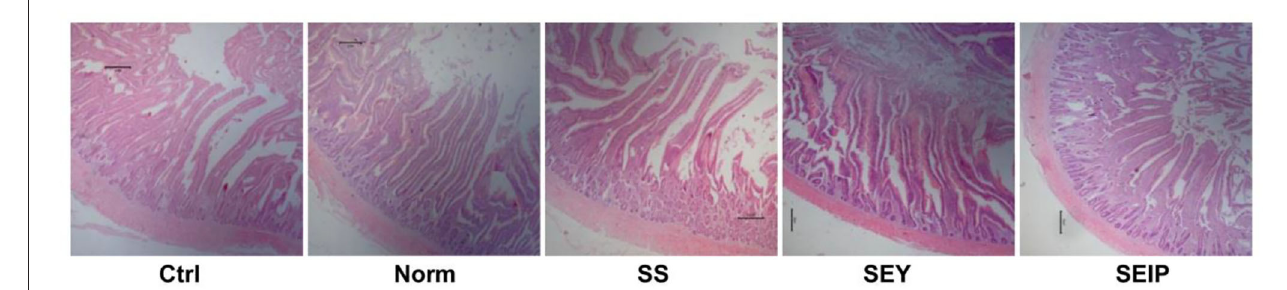
FIGURE 1 | Effects of dietary Se sources on morphology of jejunum in laying hens. The representative pictures (40 × ) of jejunum section with hematoxylin and erosion (H&E) staining. Ctrl, the birds fed the basal diet; Norm, the birds fed 0.3 mg/kg of Se provided by sodium selenite; SS, SEY, and SEIP, the birds fed 2 mg/kg of Se provided by sodium selenite, Se-enriched yeast, and Se-rich insect protein powder, respectively.